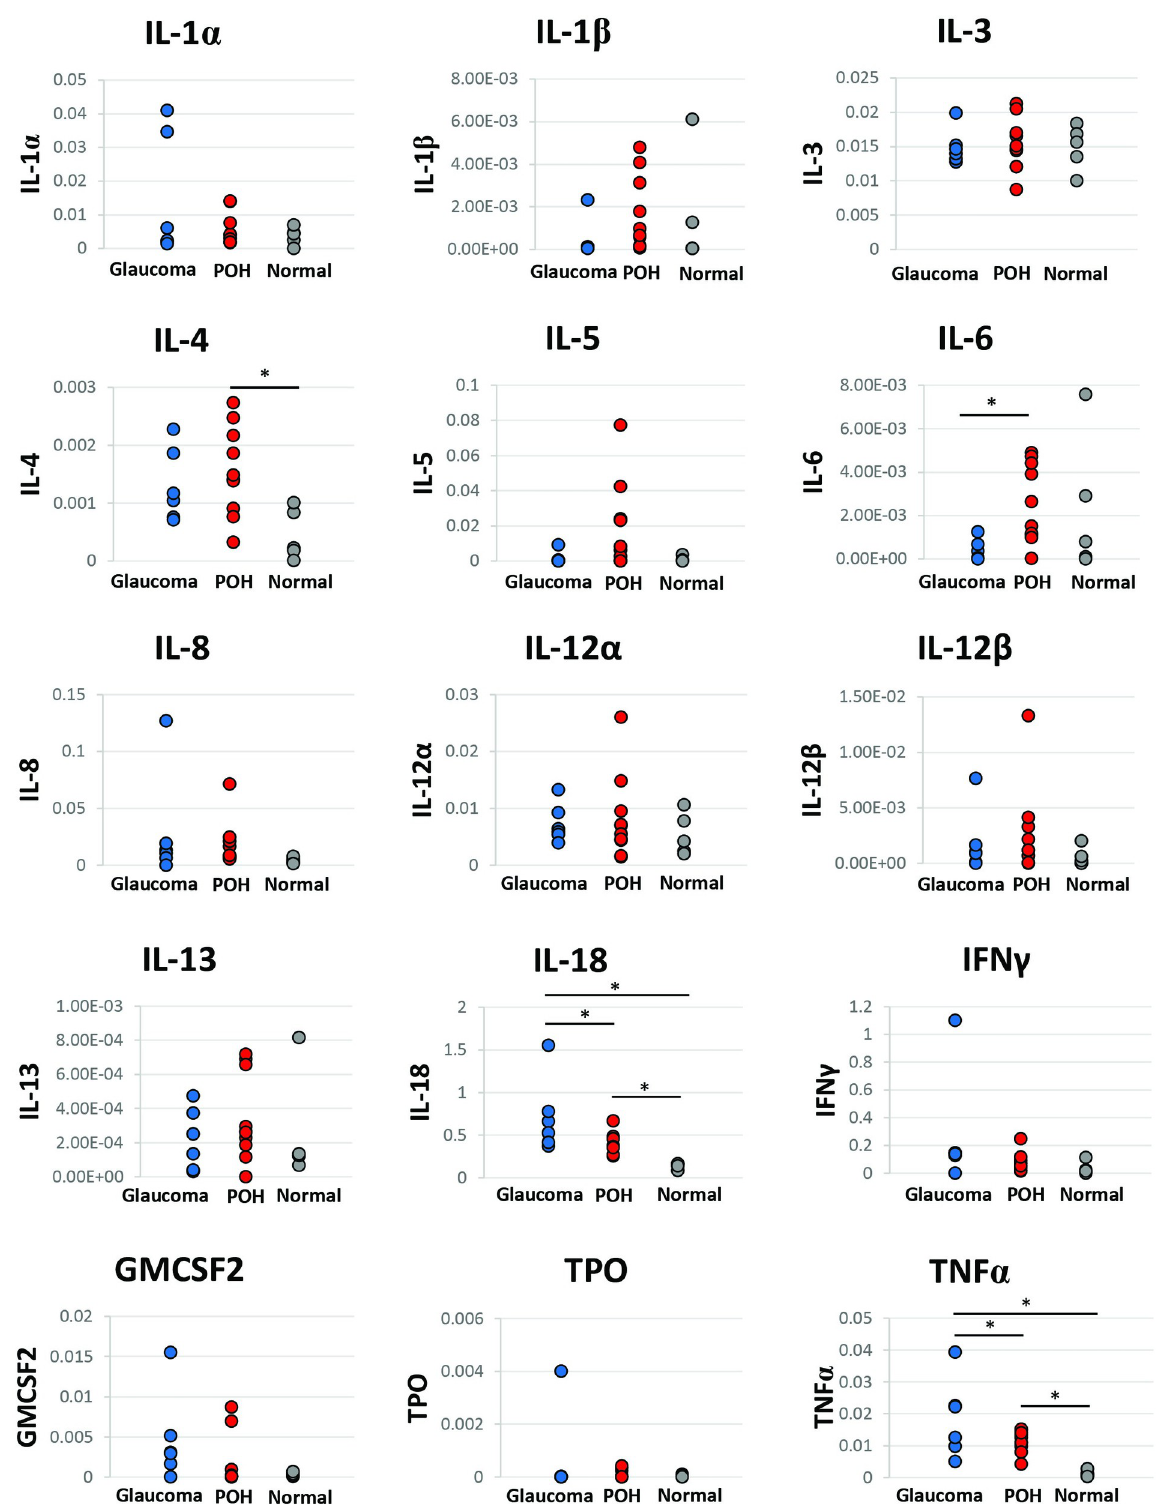
Fig 1. Cytokine levels in canine aqueous humor. Cytokine levels (normalized Total Peak Area, nTPA) in the aqueous humor (AH) of canines including Interleukin (IL) 1 α , IL-1 β , IL-3, IL-4, IL-5, IL-6, IL-8, IL-12 α , IL-12 β , IL-13, IL-18, Tumor necrosis factor-alpha (TNF- α ), Interferon- gamma (IFN γ ), granulocyte-macrophage colony stimulating factor 2 (GMCSF2), and thrombopoietin (TPO). TNF α and IL-18 levels in AH were